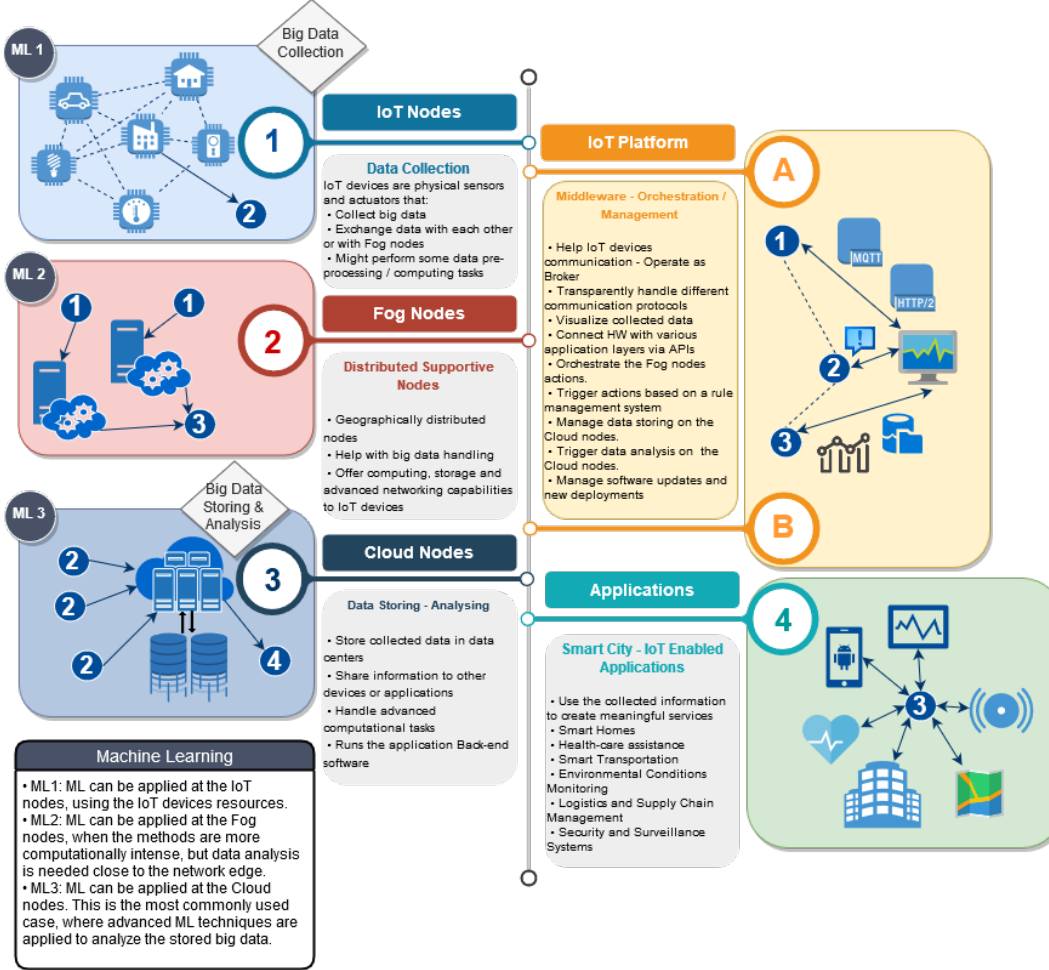
Figure 1. Key elements of the Internet of Things (IoT)